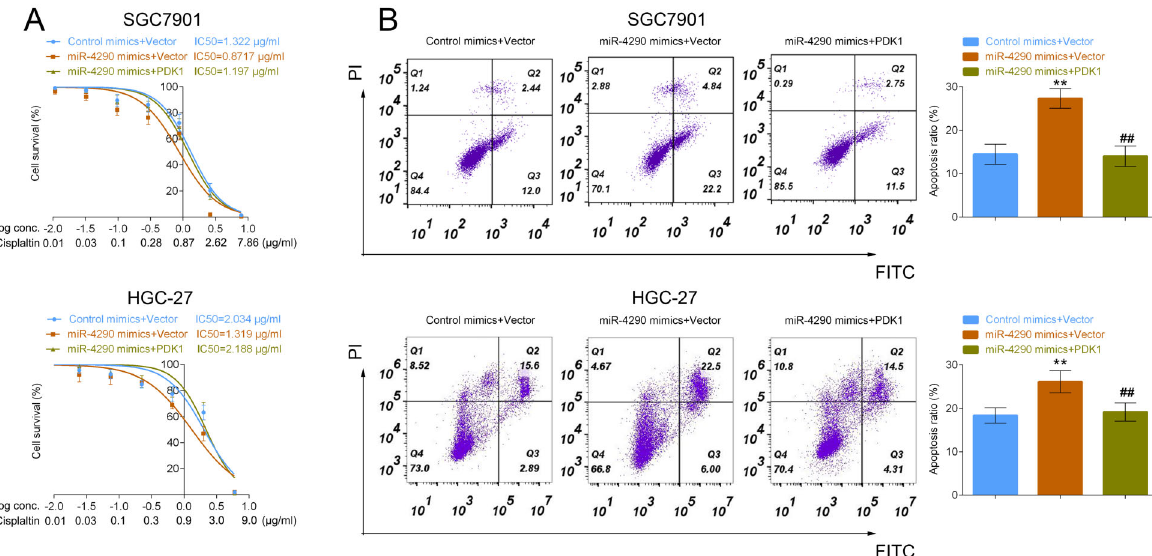
Figure 5. miR-4290 sensitized gastric cancer cells to cisplatin via downregulating PDK1 expression. A , CCK-8 assay was used to detect the concentration at 50% inhibition (IC50) value of SGC7901 and HGC-27 cells to cisplatin after the cells were transfected with Control mimics + Vector, miR-4290 mimics + Vector, and miR-4290 mimics + PDK1. B , Flow cytometry was used to detect cell apoptosis after SGC7901 and HGC-27 cells were transfected with Control mimics + Vector, miR-4290 mimics + Vector, and miR-4290 mimics + PDK1. **P o 0.01, compared with Control mimics + Vector group; ## P o 0.01, compared with miR-4290 mimics + Vector group. Data are reported as means ± SD